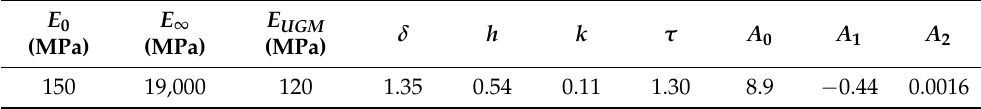
Table 1. Pavement parameters for the proposed numerical model.